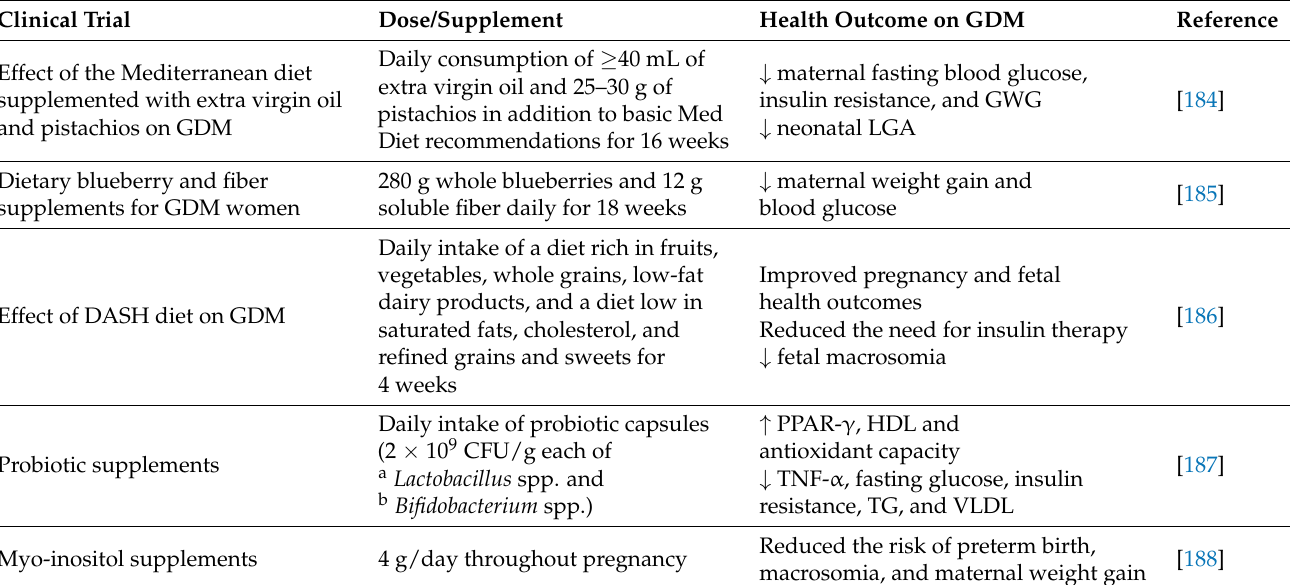
Table 2. Clinical studies in maternal diets on GDM